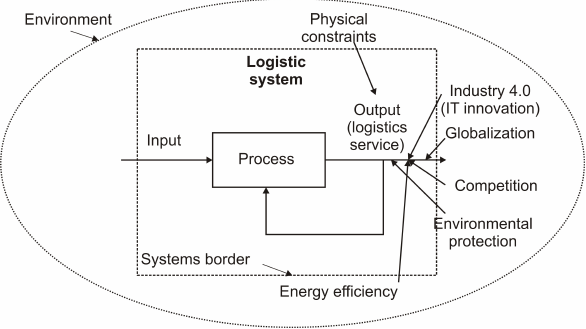
Figure 2: Transformation of context of logistics output (service), developed by